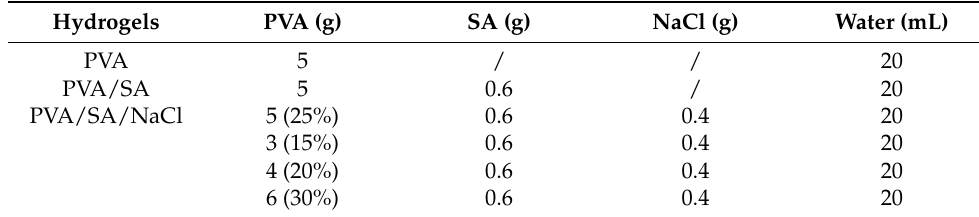
Table 1. Recipes of